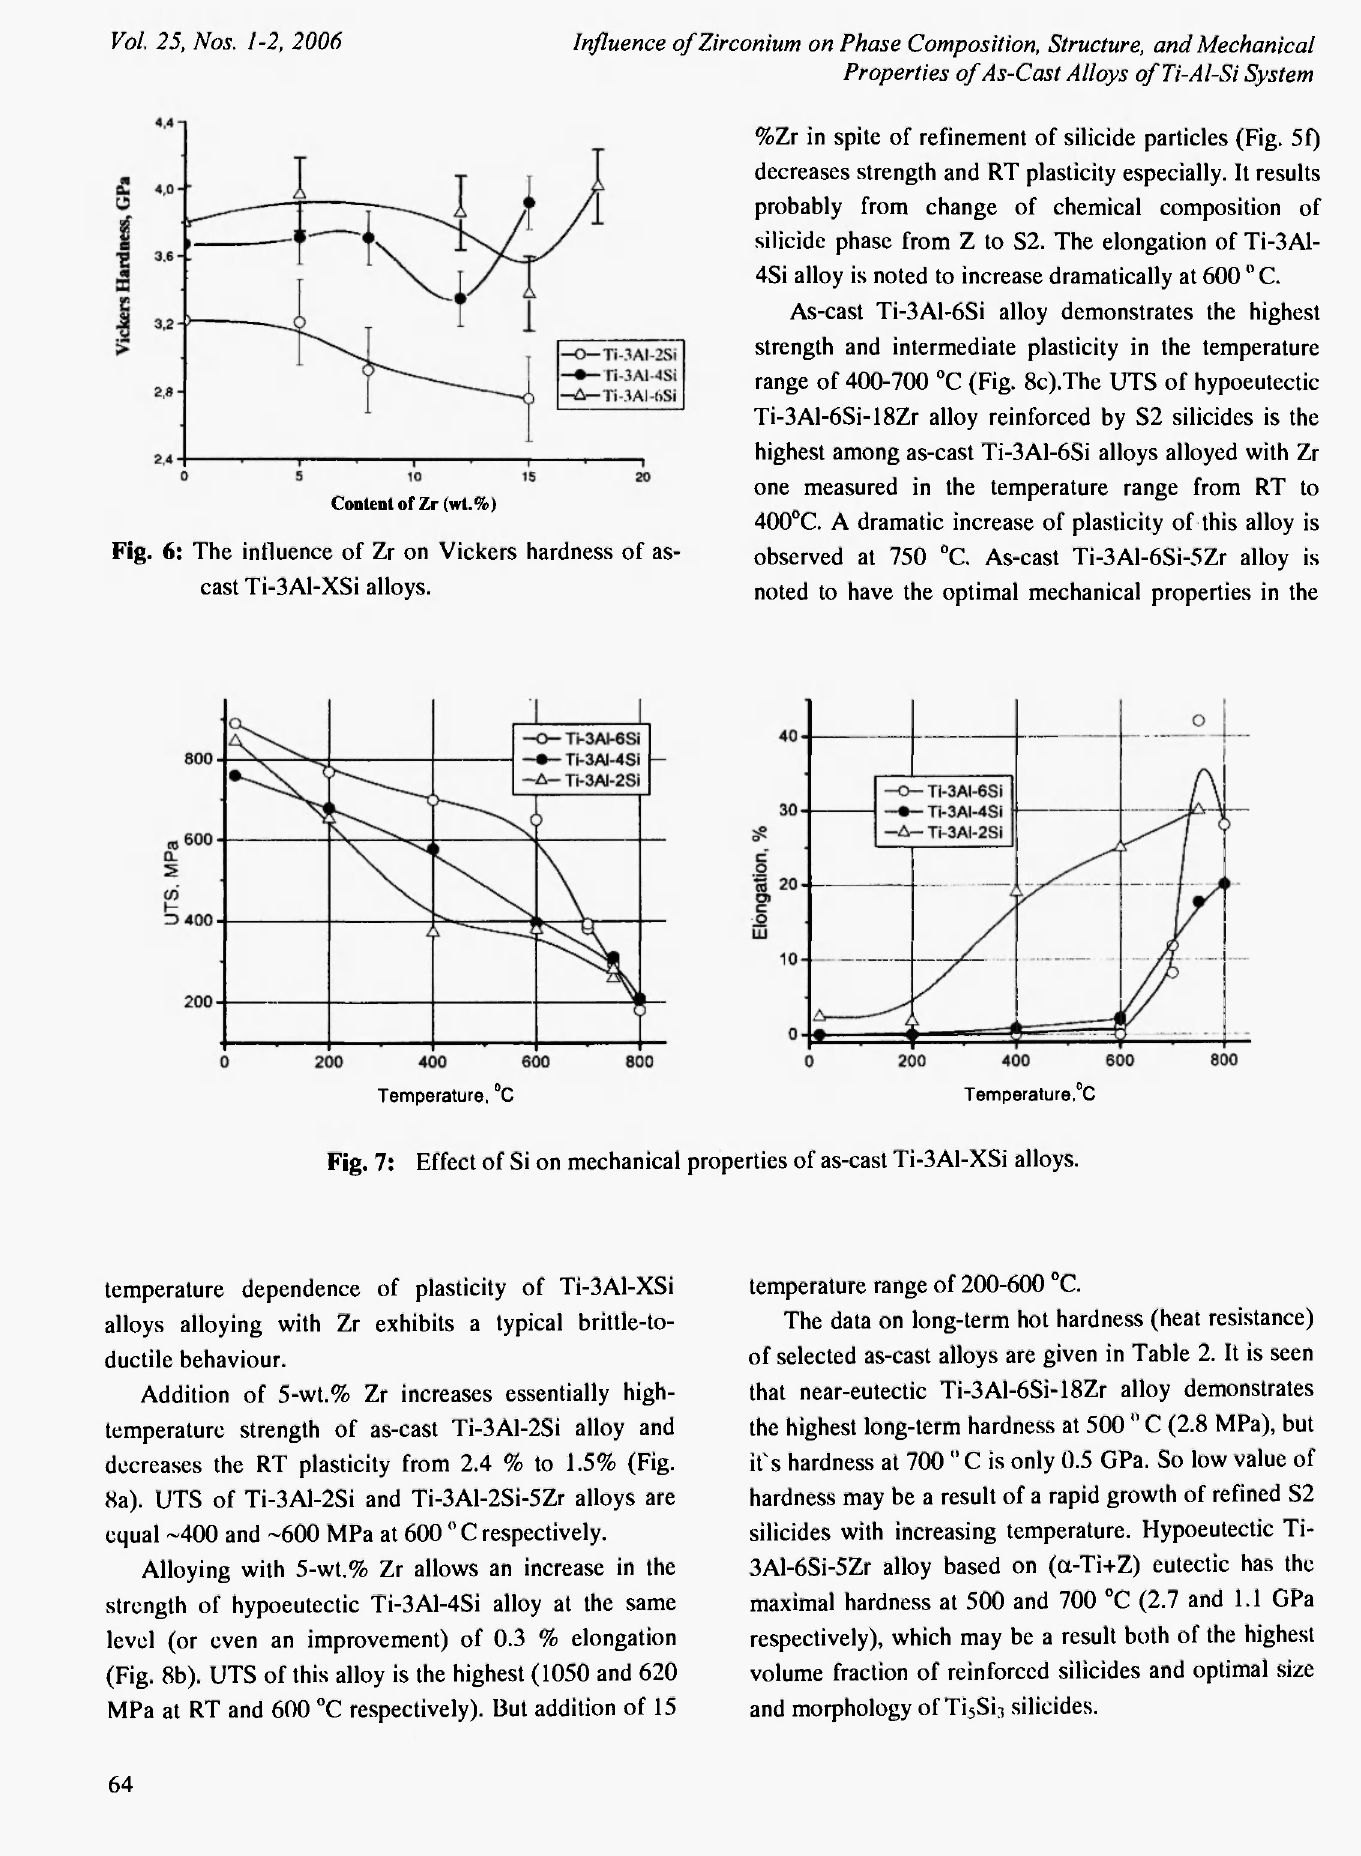
Fig. 6: The influence of Zr on Vickers hardness of as- cast Ti-3Al-XSi alloys.